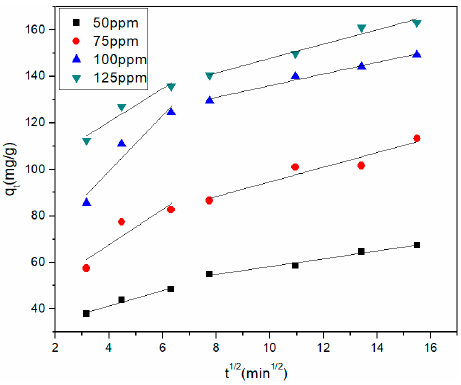
8 of 12 Table 3. Kinetic parameters for adsorption of Cu 2+ onto the rGO membrane. q e (mg·g − 1 ) and q t (mg·g − 1 ) are the amount of Cu 2+ adsorbed on the rGO membrane at equilibrium time and contact time, respectively; k 1 (min − 1 ) and k 2 (g (mg min) − 1 ) are the rate constants of the pseudo-first-order and pseudo-second-order models, respectively. Kinetic Model